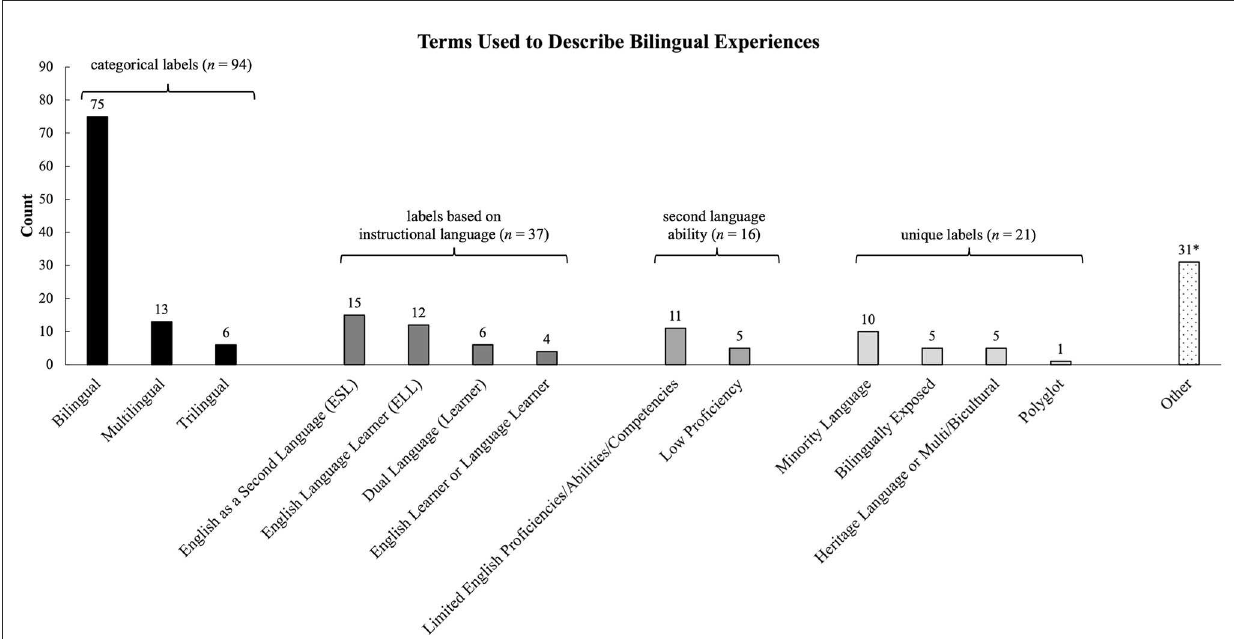
FIGURE2 *”Other” terms included the following descriptions: “second-language English speakers,” “all of them had an exposure to English through nursery rhymes,” “exposed to Spanish and English in the home environment,” “multiple languages in the workplace,” “...parents spoke a primary language other than English in the household,” “limited or non-English competencies,” “not native English speakers,” “proficient bilingual children,” “English was not the primary language spoken at home,” “English as secondary language learning and teaching process,” “was exposed to more than one language on a daily basis,” “English as an Additional language (EAL),” “English as a second/non-native language,” “second language exposure (SE),” “bilingual English and Spanish,” “home language,” “English not primary language at home,” “culturally and linguistically diverse (CLD),” “non-English speaking families,” “a native language other than the majority language,” “obligatory bilinguals,” “exposure to two or more languages at home,” “mother-tongue at home,” “two or more additional languages,” “native language,” “native speakers of Mandarin Chinese with basic knowledge of English,” “a bilingual child was defined as a child who was exposed to both English and Spanish at home, regardless of their expressive or receptive abilities in either language,” “bilingual English-Spanish,” “more than one language spoken at home,” “emerging bilinguals,” “English-proficient bilinguals,” “who come from a home that speaks any language other than English,” “Chinese-English bilingual children,” “families who speak more than one language,” “home language environment/HLE,” “dual-language home environment,” BLH (bilingual home environment), and “spontaneously acquired the English